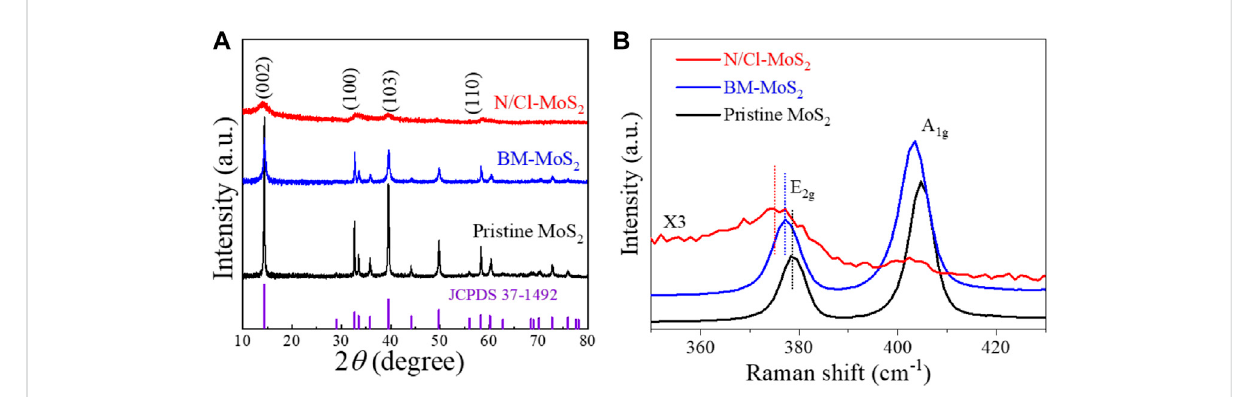
FIGURE 2 (A) XRD patterns of pristine MoS 2 , BM-MoS 2 , and N/Cl-MoS 2 . (B) Raman spectra of pristine MoS 2 , BM-MoS 2 , and N/Cl-MoS 2